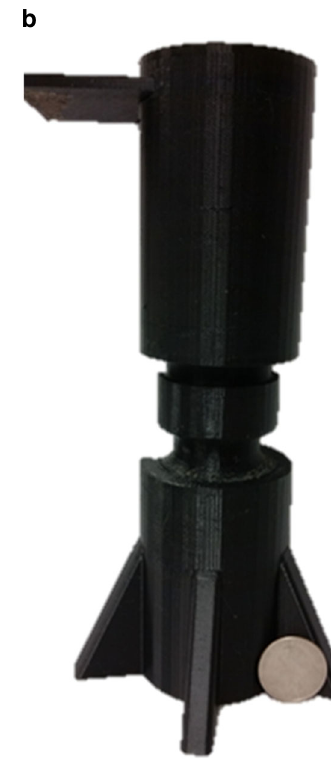
Fig. 1 Lens-free holographic imaging system. a Schematic of the lens-free sensor system showing internal components of the device. The device consists of a partially coherent light-source (created by coupling the light from an LED into an optical fi ber that passes through a band-pass fi lter) illuminating the sample before being detected by the CMOS imaging sensor. b The 3D-printed physical hardware, with a quarter coin placed in front of